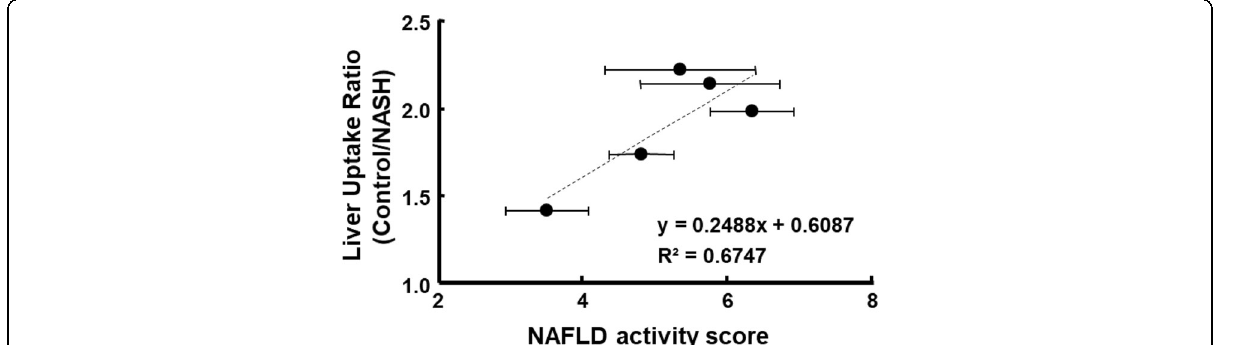
Fig. 6 The relationship between the liver uptake ratio (control/nonalcoholic steatohepatitis (NASH)) and nonalcoholic fatty liver disease (NAFLD) activity score of NASH